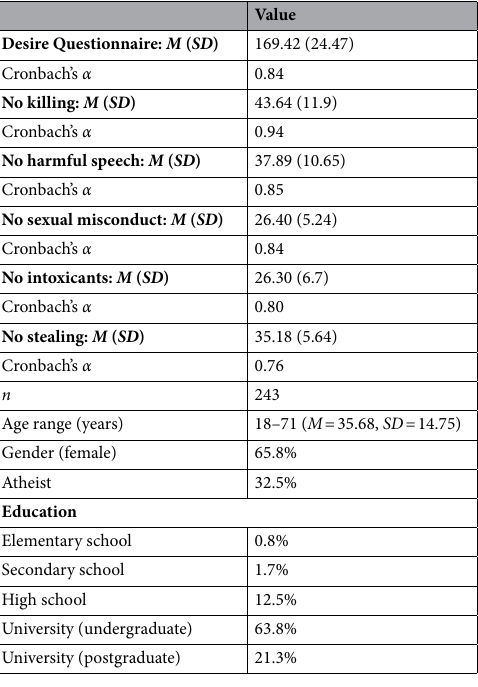
Table 1. Sample characteristics and DQ scores for the exploratory factor analysis. Sample consisted of general adults in